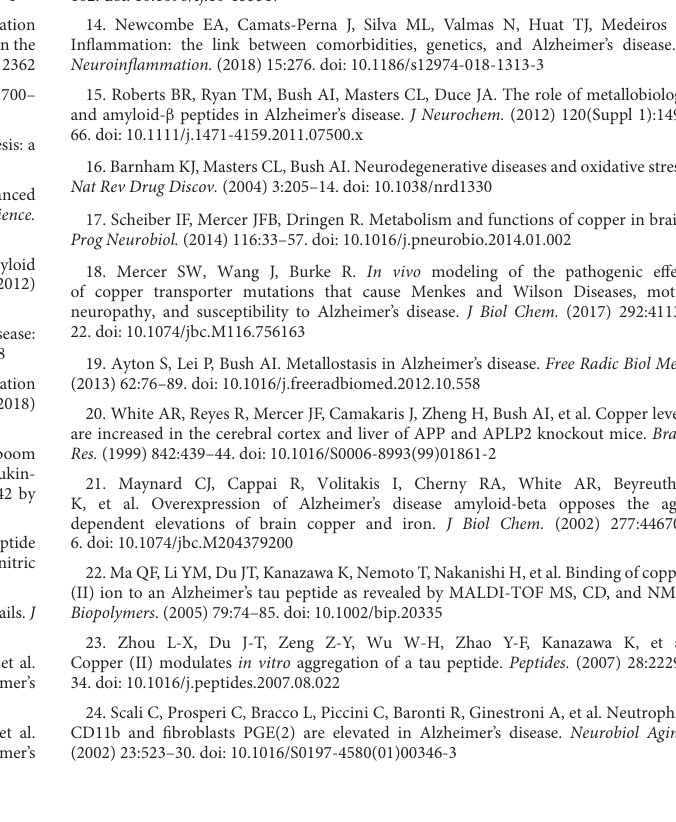
SUPPLEMENTARYTABLE1 Differentially expressed genes between AD and ND samples in GSE33000.